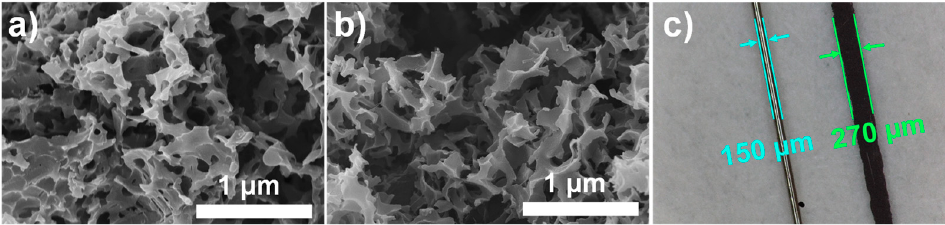
Figure 1. SEM images of N-SPCs ( a ) and PAA/N-SPCs ( b ), and optical microscope image of as-prepared SPME fiber before and after coating ( c ).